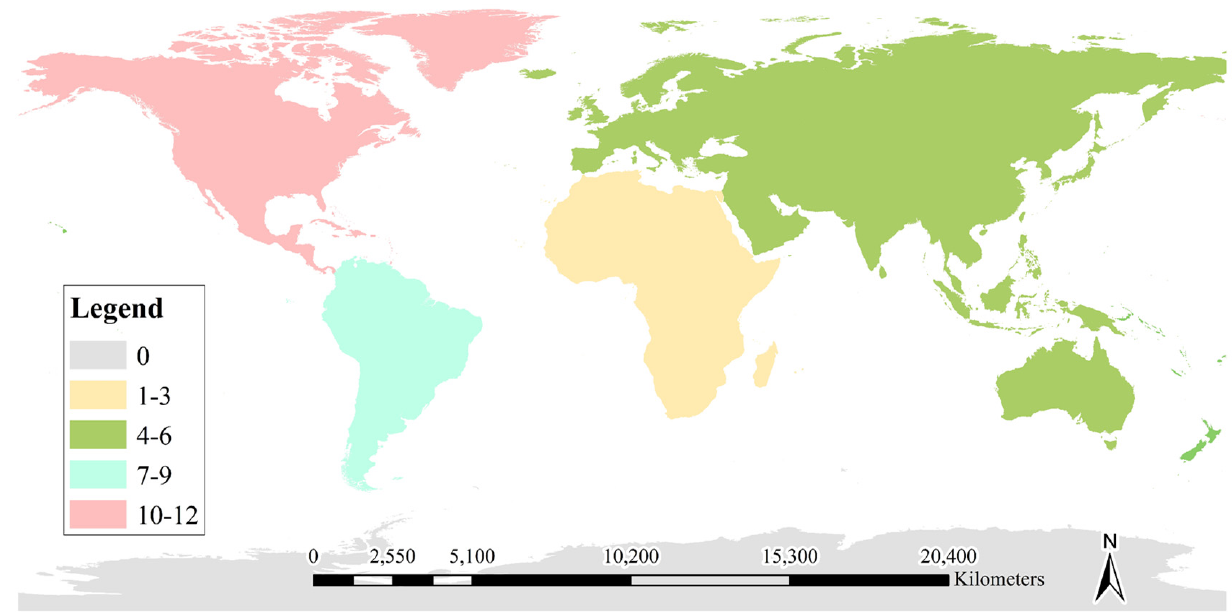
Figure 3. Spatial distribution and number of studies conducted at continental level.